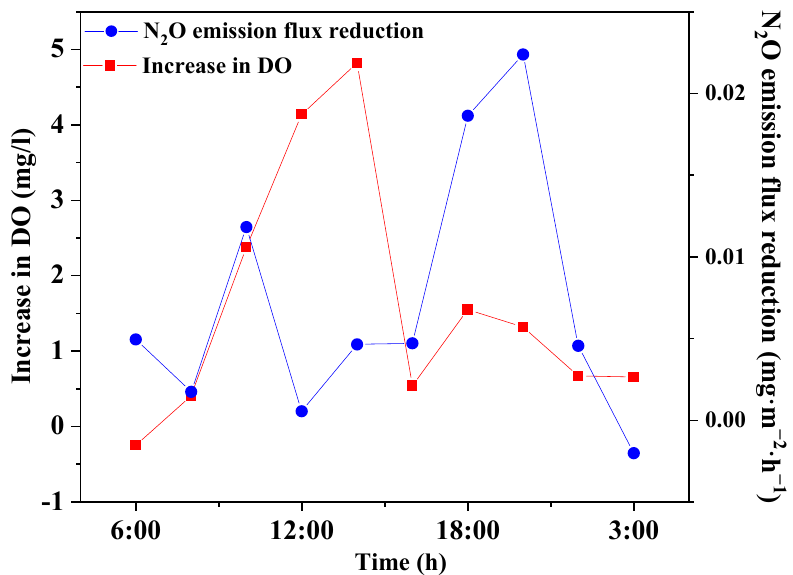
Figure 8. Relationship between the water DO increment and N 2 O emission flux reduction in the agricultural drainage ditch .